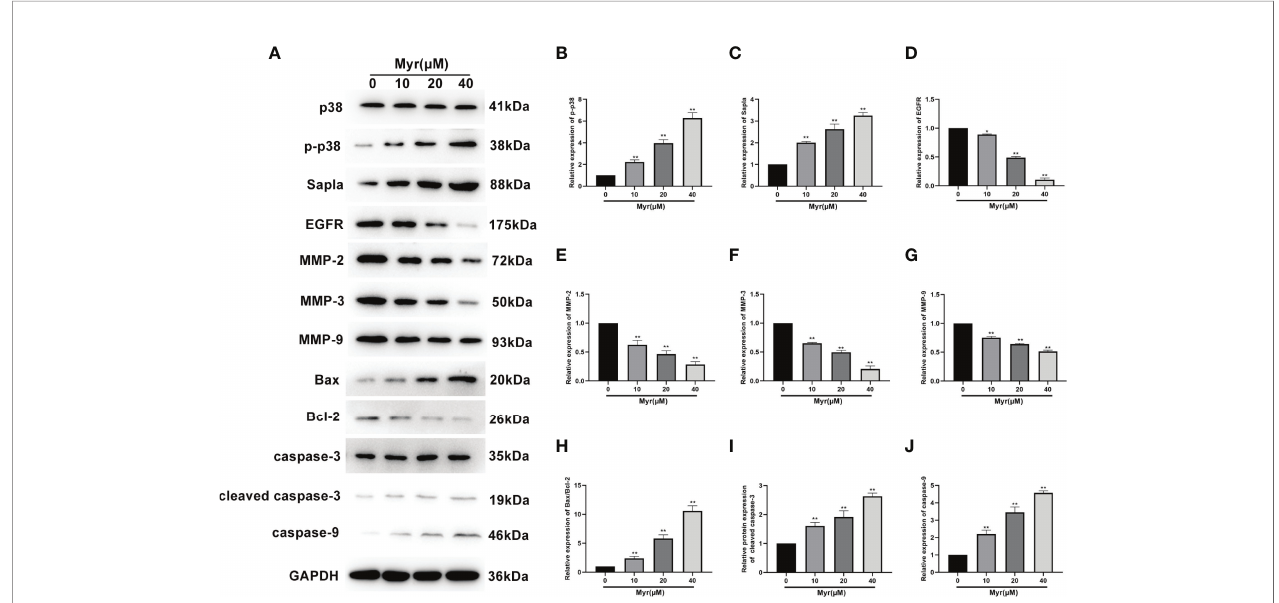
FIGURE 6 | Effects of different Myr concentrations on expression of proliferation-, migration-, and invasion-related proteins in SKOV3 cells. (A) Western blot analysis image. Relative levels of (B) p-p38, (C) SAPLA, (D) EGFR, (E) MMP2, (F) MMP3, (G) MMP9, (H) Bax/Bcl-2, (I) cleaved caspase-3, and (J) caspase-9, were determined using western blot analysis. n=3; * p <0.05, ** p <0.01 vs. control.